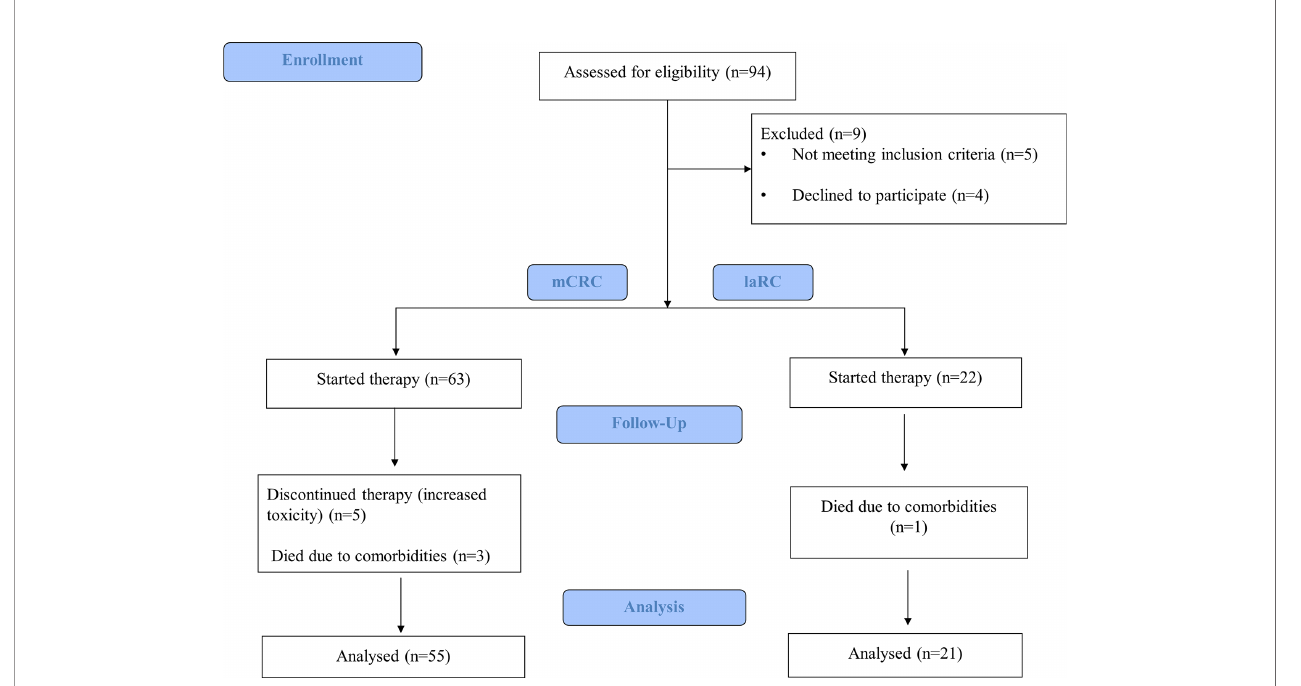
FIGURE 1 | CONSORT fl ow diagram of our